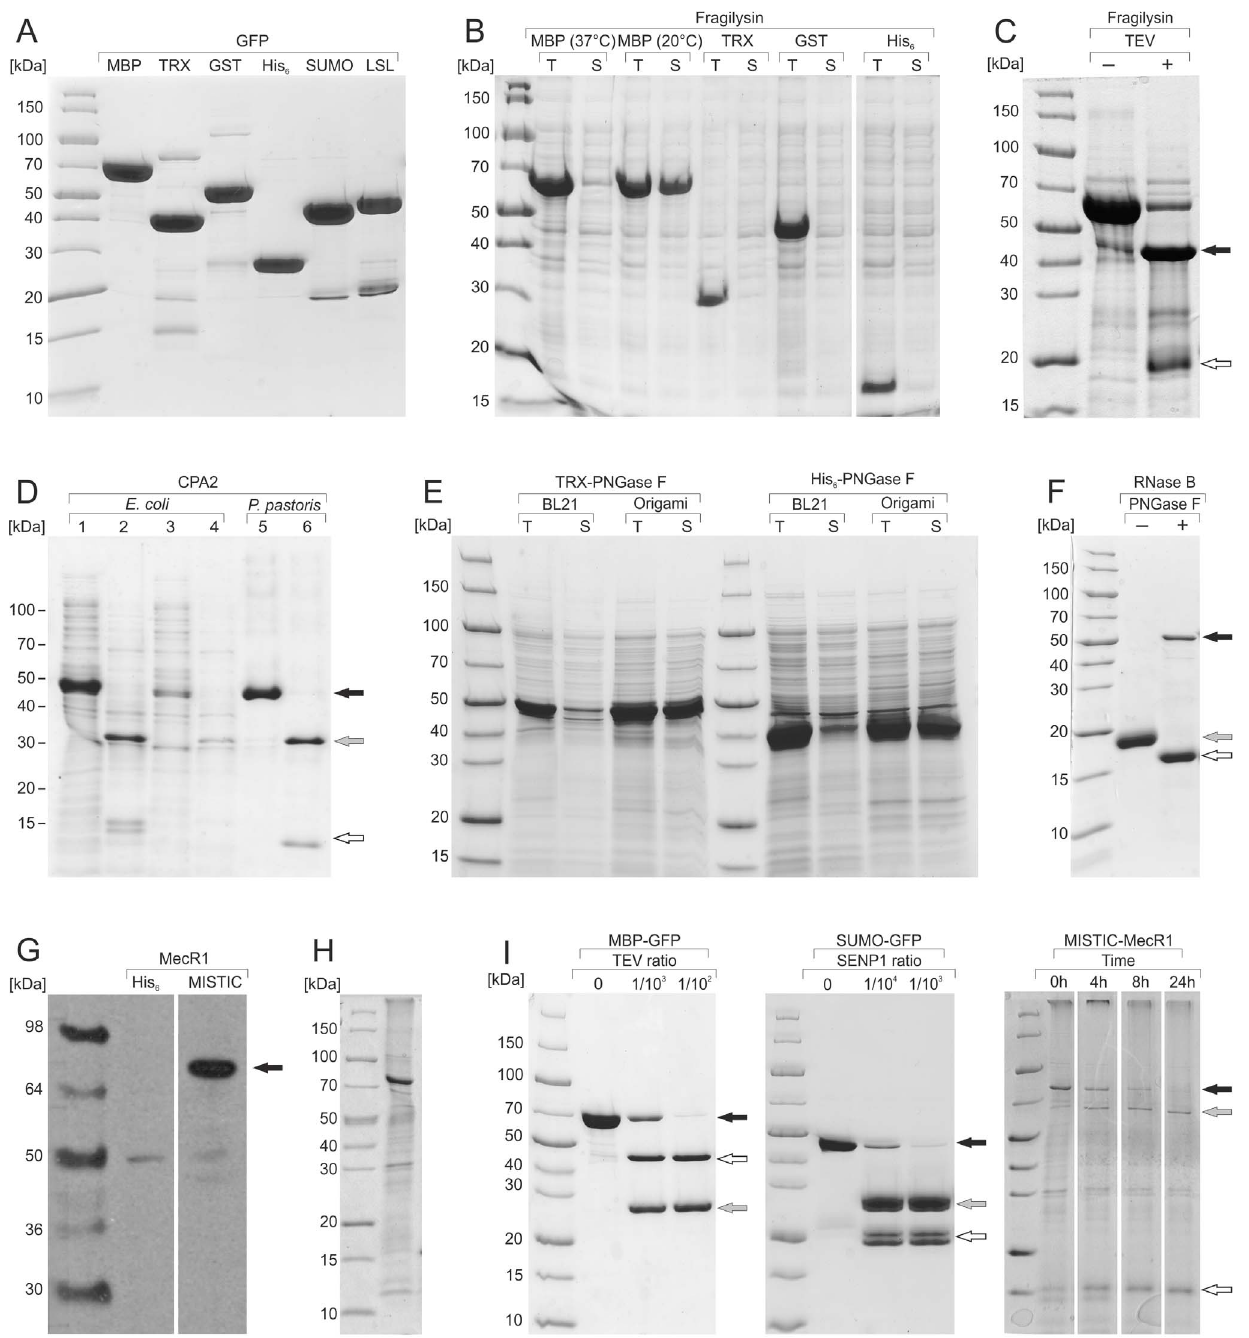
Figure 2. Protein expression and purification trials using the pCri System. ( A ) The GFP gene was cloned into pCri-1a, 4a, 6a, 8a, 11a, and 14a, the proteins expressed in E. coli BL21 cells, and subsequently purified by Ni-NTA-affinity chromatography except for MBP, GST, and LSL fusion products, which were purified by their respective specific affinity resins. ( B ) The gene coding for fragilysin was cloned into pCri-1a, 4a, 6a and 8a, and expressed in E. coli Origami 2 cells. Total (T) and soluble (S) fractions of crude protein extracts were further analysed by SDS-PAGE. All expression trials were performed at 20 u C except for pCri-1a, which was also performed at 37 u C. ( C ) Partially purified MBP-fragilysin before ( 2 ) and after ( + ) TEV proteinase cleavage. Arrows indicate the soluble fraction of fragilysin (white) and the MBP (black) after TEV proteinase cleavage. ( D ) Expression of CPA2 intracellularly (lanes 1 and 2) or periplasmatically (lanes 3 and 4) in E. coli cells, and extracellularly (lanes 5 and 6) in P. pastoris cells. Lanes indicate samples before (1, 3 and 5) and after (2, 4 and 6) tryptic digestion. Arrows indicate the pro-CPA2 (black), the mature form (grey) and the pro- peptide (white) after tryptic cleavage. ( E ) The PNGase F gene was cloned into pCri-4a and 8a and expressed overnight at 20 u C in E. coli BL21 and Origami 2 cells. Total (T) and soluble (S) fractions of crude protein extracts were further analysed by SDS-PAGE. ( F ) Activity of affinity-purified TRX- PNGase F against glycosylated RNase B. ( + ) and ( 2 ) indicate presence and absence of PNGase F. Arrows indicate the PNGase F (black), native RNase B (grey) and deglycosylated RNase B (white). ( G ) MecR1 was expressed in E. coli BL21 using pCri-8a or 13a, and soluble fractions were analysed by Western blotting with specific antibodies as detailed in ‘‘Materials and Methods’’. A black arrow indicates the detected MecR1. ( H ) Partially purified MISTIC-MecR1 after Ni-NTA-affinity purification. ( I ) Partially purified MBP-GFP, SUMO-GFP and MISTIC-MecR1 were digested with TEV proteinase,